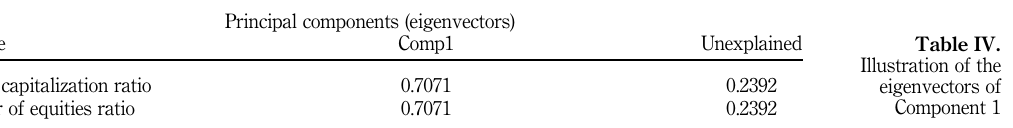
Table IV. Illustration of the eigenvectors of Component